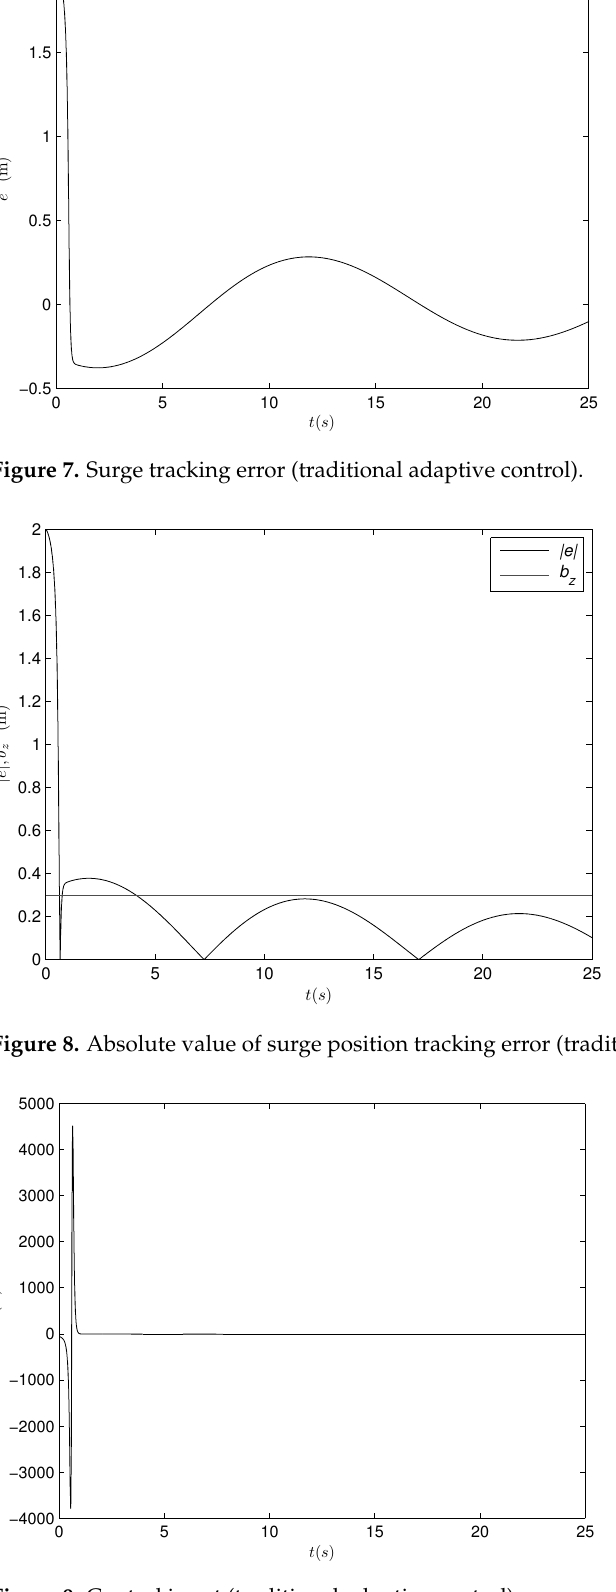
Figure 9. Control input (traditional adaptive